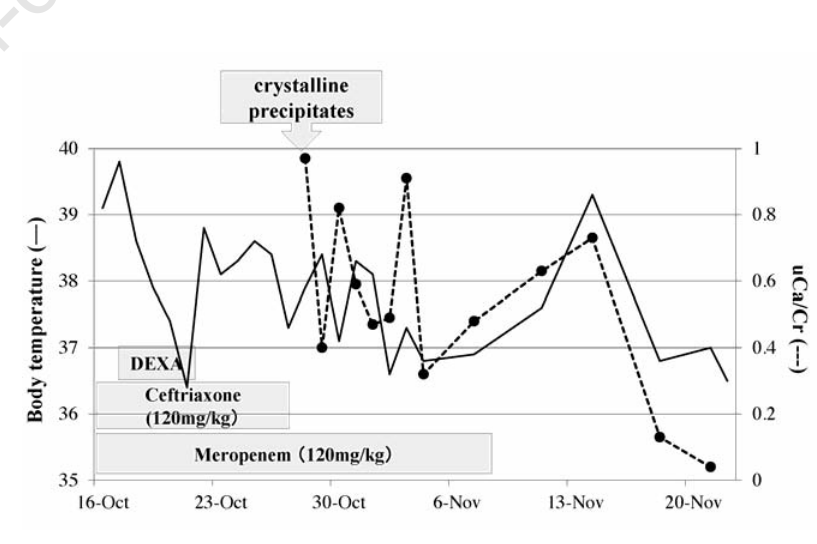
Figure 1. The clinical course of the index case with bacterial meningitis.The solid line and dashed line denote the body temperature and urinary calcium excretion, respective- ly. uCa/Cr, urinary calcium to creatinine ratio; DEXA,